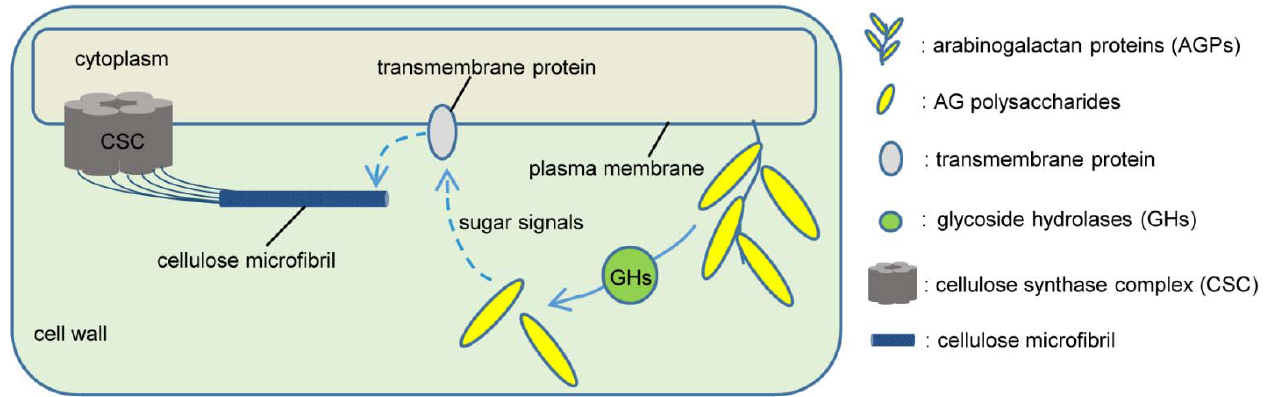
Figure 4. A putative mechanism is an enzymatic release of AG polysaccharides from AGPs that may act as signal molecules possibly recognized by plasma membrane receptors. The sugars may be cleaved by glycoside hydrolases and may function as signal molecules binding to specific receptors, as proposed by Showalter [2].